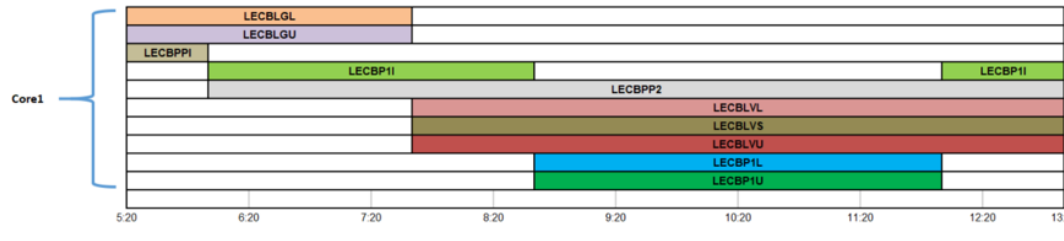
Figure 9. Sectorization of instance 1.